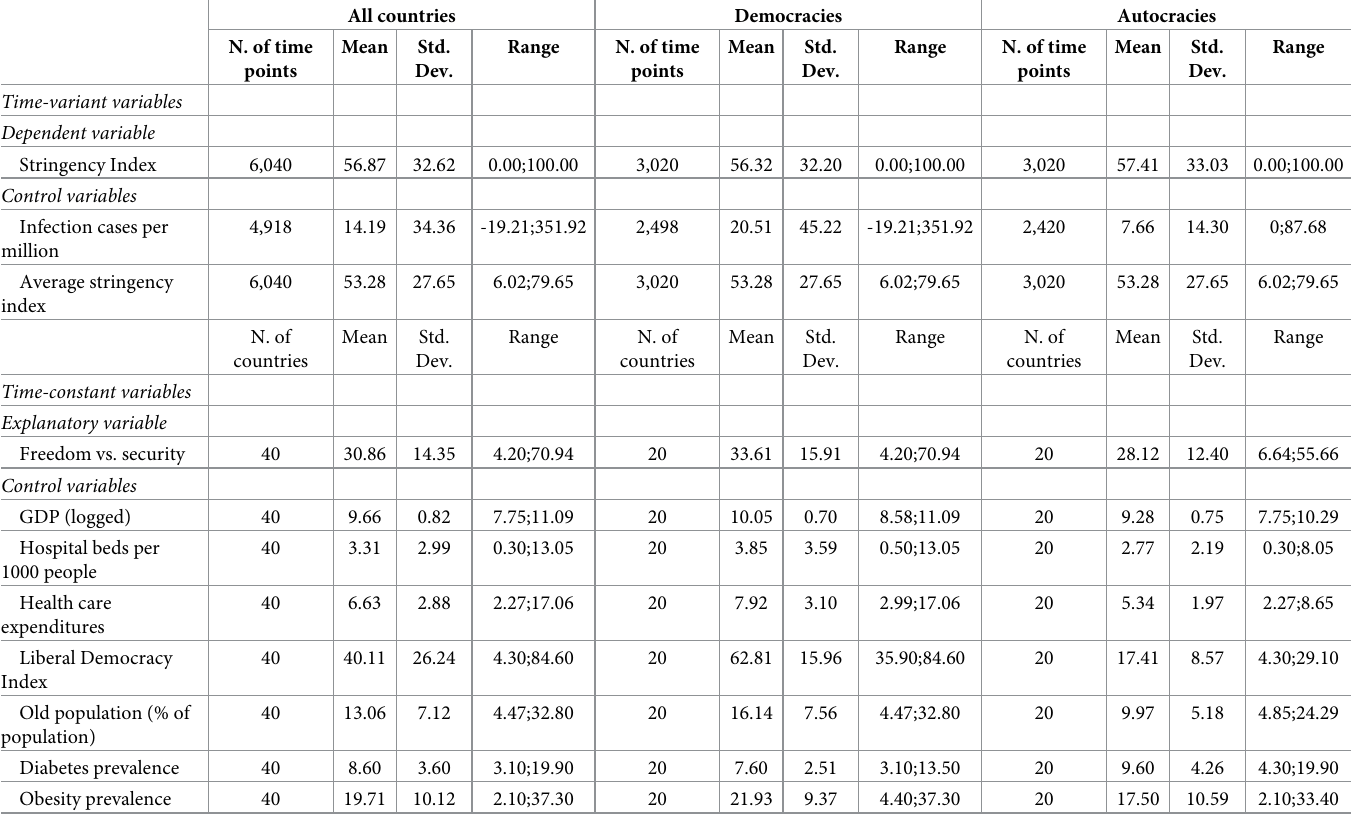
Table 1. Descriptive statistics for all variables included in the